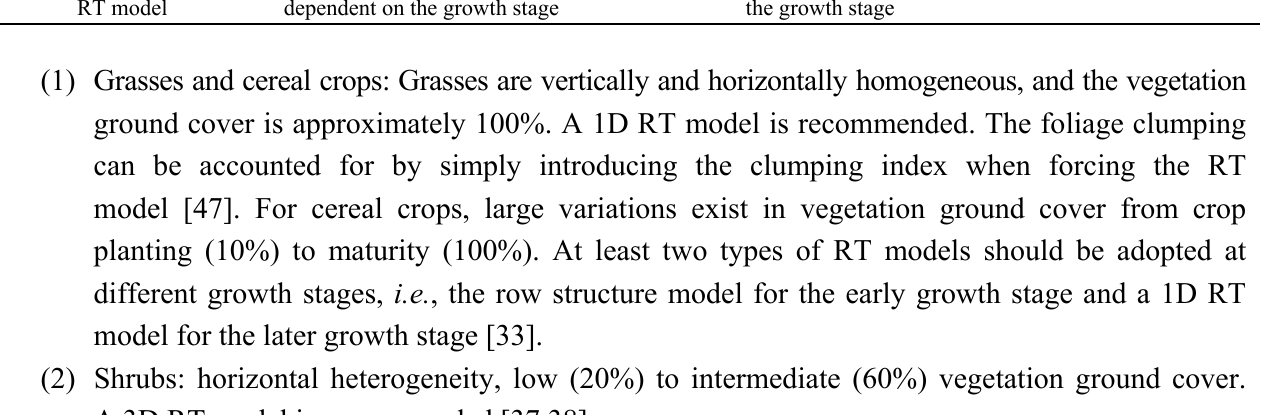
Broadleaf Broadleaf Needle Shrubs Savannas Crops Forests